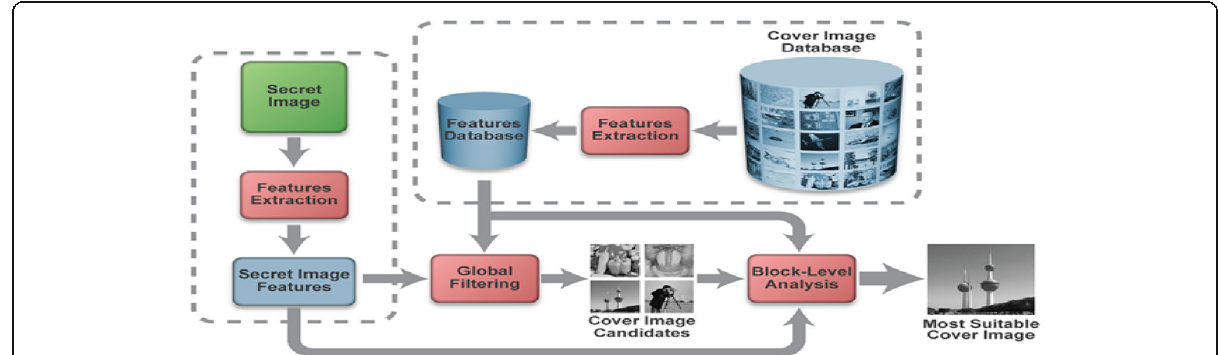
Fig. 7 The pipeline of the most suitable cover image (MSCI)